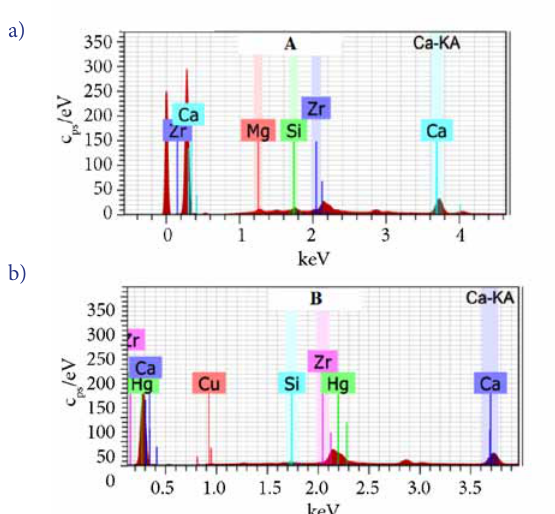
Fig. 4. (a) EDX results of tobacco leaf before biosorption (b) EDX results of tobacco leaf after biosorption